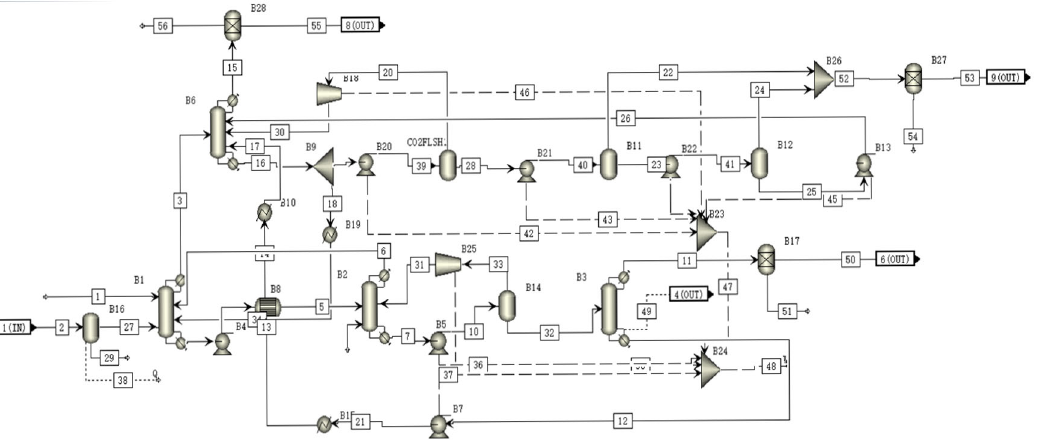
Figure 4. A schematic of the CLEAN module flowsheet. The absorption efficiency of CO 2 and H 2 S of the CLEAN subunit are 97% and 95%, which is proximate to the reported data [30]. Table 5 shows the materials and parameters of all streams in CLEAN module. Table 5. Stream parameters in